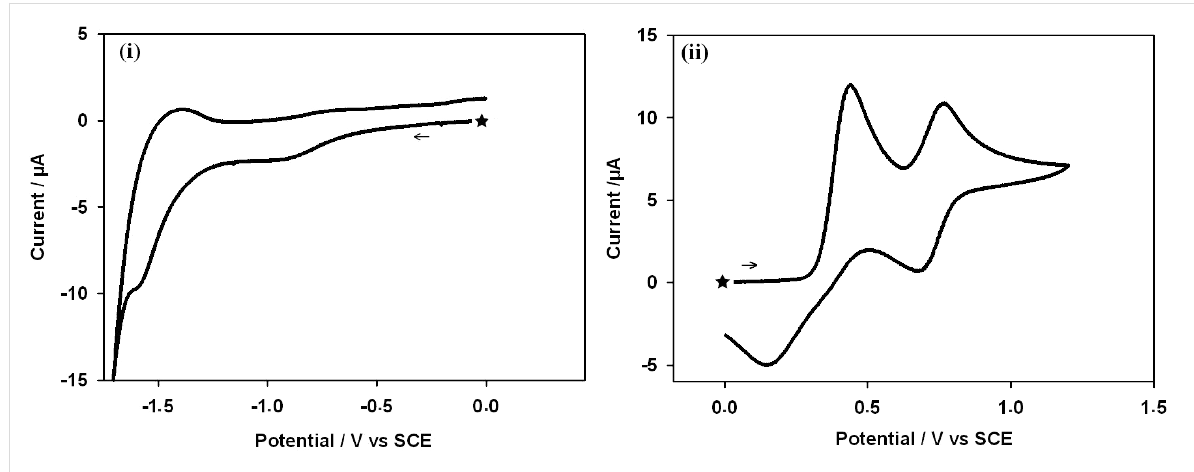
Figure 10: Cyclic voltammogram of 1a in CH 3 CN (0.1 M NBu 4 PF 6 ): (i), (ii) cathodic and anodic range of the voltage scan. Scan rate 100 mV·s −1 . The black star denotes the initial and final potential.